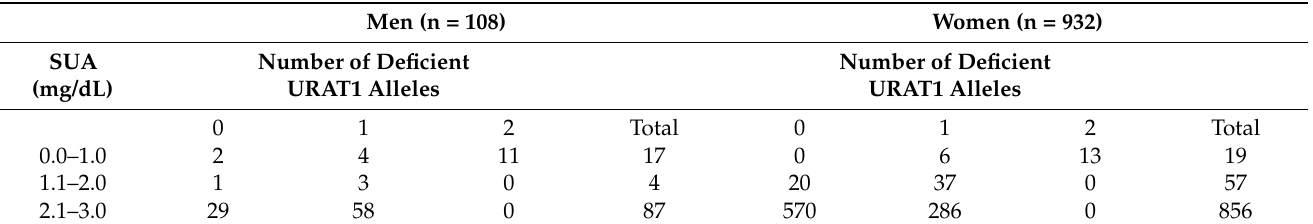
Table 2. Frequency of mutant URAT1 alleles (W258X and R90H) in individuals with low SUA concentrations